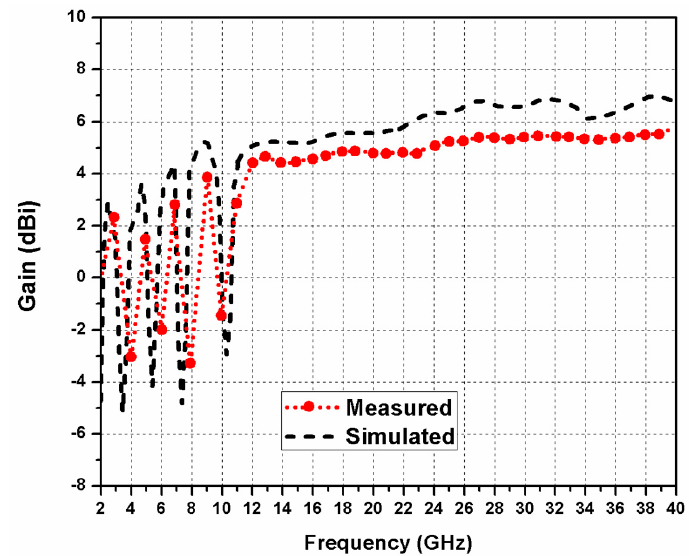
Figure 9. Gain of the proposed quad band-notched SWB antenna.